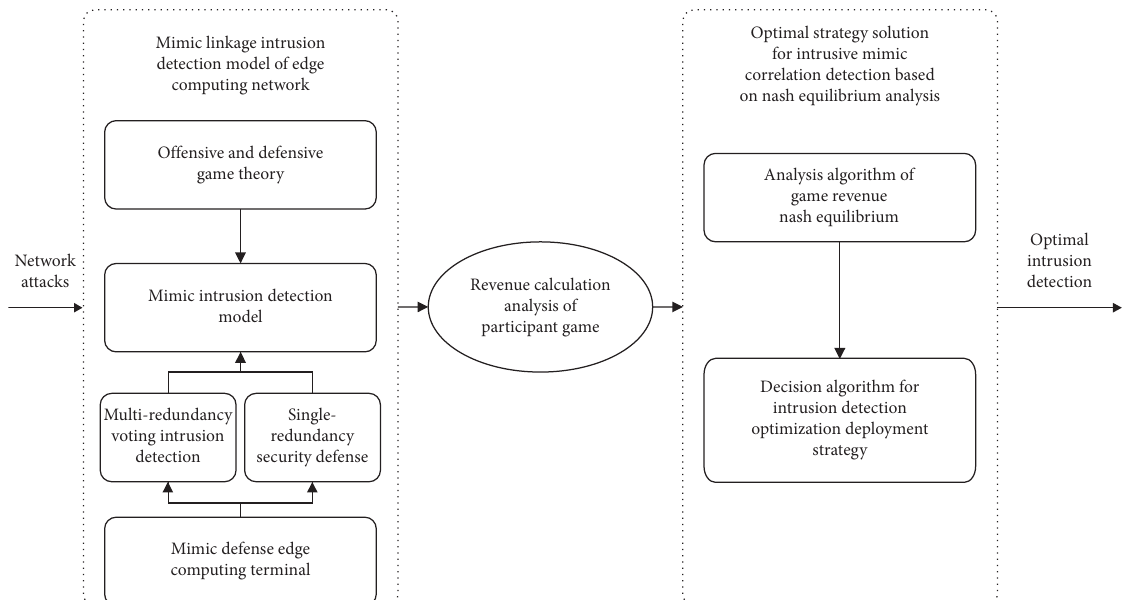
Figure 1: The schematic of the active optimization deception defence of edge computing network